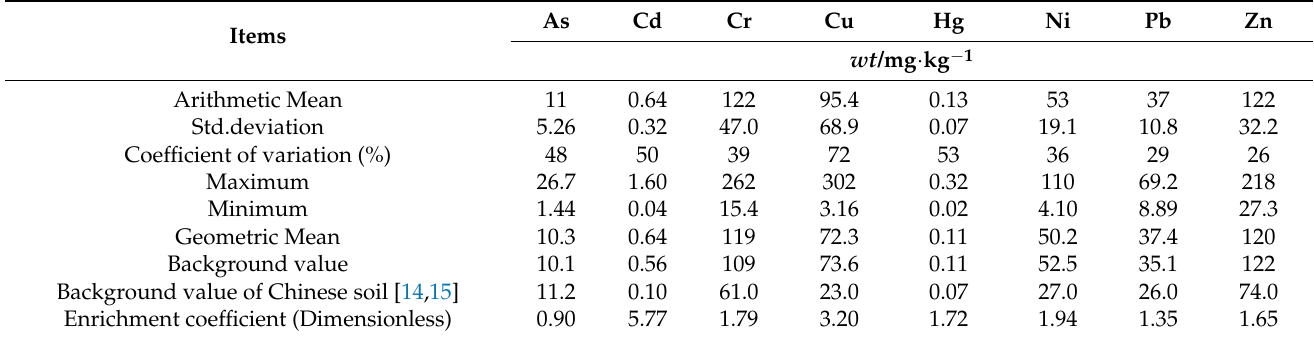
Table 4. Descriptive statistics for heavy metal concentrations in surface